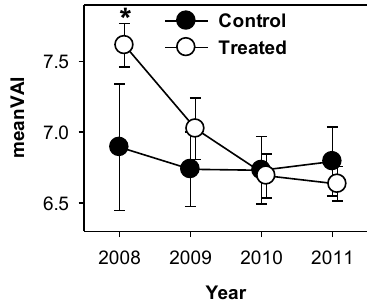
Figure 5. MeanVAI (vegetation area index) declined in treated, but not in control plots following girdling. * indicate significant differences between treated and control plot